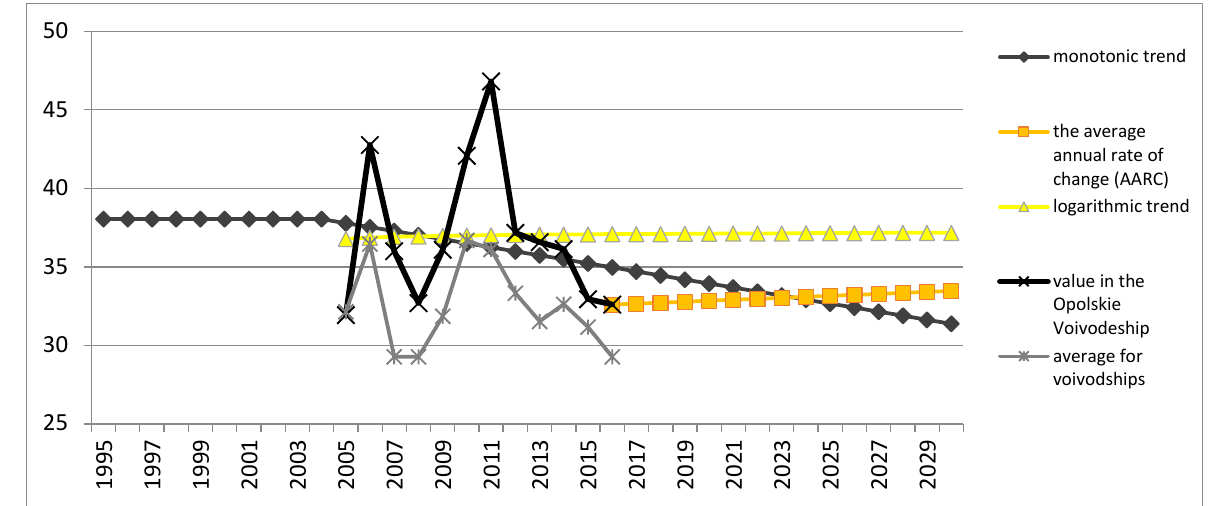
Figure 5. The average daily PM10 pollution. Source: own elaboration.